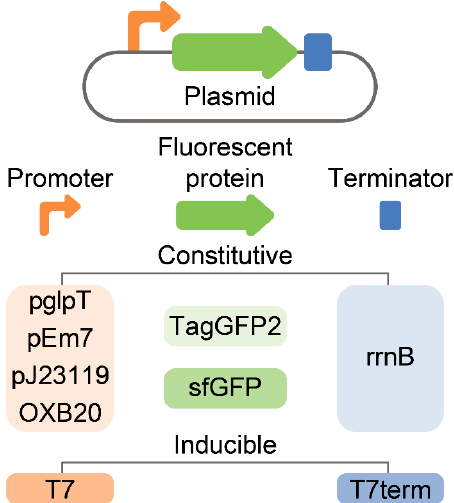
Figure 2. Cell morphology of different E. coli strains visualized by fluorescence microscopy. GFP- producing reporter S. aureus cells were used as a control. BL21(DE3) and TG1 strains of E. coli were suitable as a template for the creation of live biosensors since they provided homogeneous cell cultures with a high level of cell fluorescence. Other strains were inappropriate as a reporter. Rosetta (DE3) had a mediocre fluorescence. Xl-1 had a stretched morphology with a high number of odd rod cells. SHuf- fle T7 formed cell aggregates. Further, E. coli BL21(DE3) was used for live biosensors’ en- gineering.